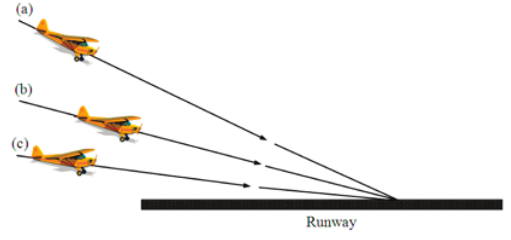
Fig. 6 . Various approach paths during landing The lift